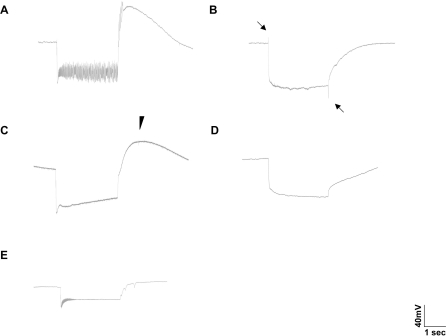
Thioperamide and Immepip Treatment Rescues Oscillations in ine2 ERGs and Ablates Transients in w1118 FliesERG recordings from untreated (A) ine2 and (B) w1118 and 0.5% thioperamide-treated (C) ine2 and (D) w1118, and (E) 0.5% immepip-treated ine2 flies. Note that while ERG recordings from untreated ine2 mutants display oscillations and a hyperpolarization response, treatment of ine2 flies overnight with 0.5% thioperamide results in a loss of oscillations and on and off transients but not the hyperpolarization response (arrowhead). (E) Treatment of ine2 flies overnight with 0.5% immepip results in a loss of oscillations and hyperpolarization response in >50% of ine2 mutants tested.